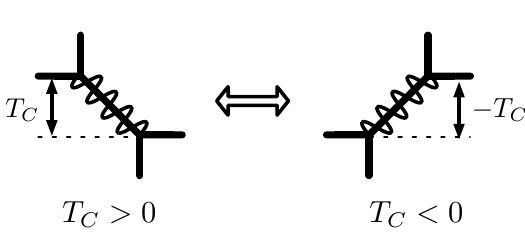
Figure 7 . String generating BPS particle with spin ( j